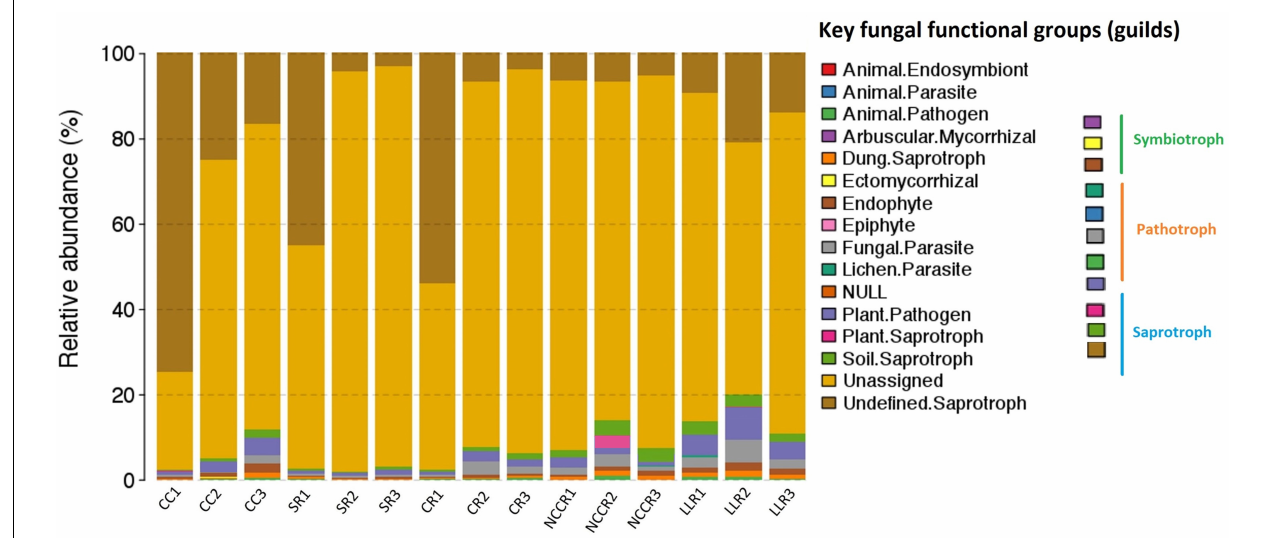
FIGURE 6 | Relative abundance of fungal functional groups (guilds) inferred by FUNGuild in different treatments. CC1-CC3 represents samples from continuous cucumber cropping; SR1,SR2 and SR3 from spinach rotation; CR1-CR3 indicates samples from coriander rotation; NCCR1-NCCR3 from non-heading Chinese cabbage rotation, and LLR1-LLR3 from leafy lettuce